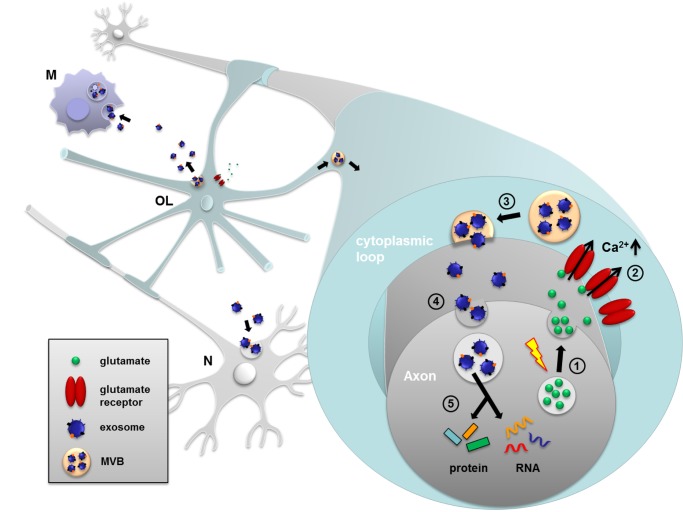
Oligodendroglial exosome secretion and its role in reciprocal neuron-glia communication.Electrically active axons release the neurotransmitter glutamate (1) inducing Ca2+-entry through oligodendroglial glutamate receptors (2). The rise in intracellular Ca2+ triggers exosome release from oligodendrocytes (OL) along internodes or at somas (3). In turn, exosomes are internalized by neurons (N) at axons or cell bodies (4) and their protein and RNA cargo is functionally retrieved (5). Exosome uptake by microglia (M) is also indicated.